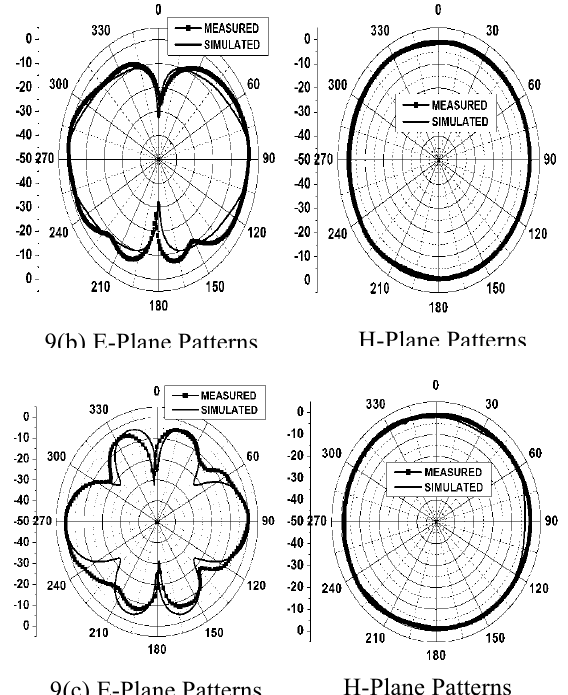
Figure 9: Simulated and measured radiation patterns of CSA (a) E-Plane and H-Plane patterns at 0.5 GHz (b) E-Plane and H-Plane patterns at 3 GHz (c) E-Plane and H-Plane patterns at 3.6 GHz CSA antenna exhibits good radiation patterns with figure of eight patterns in E-Plane and omnidirectional patterns in H-Plane. The 3 dB beamwidth of the E-Plane patterns of antenna varies from 35º-66º. The maximum deviation from omnidirectionality in H-Plane patterns is within ± 1.5dB. Comparison of the simulated and measured gain of CSA is shown in fig. 10. The measured Gain varies from 0 to 3.6dBi.